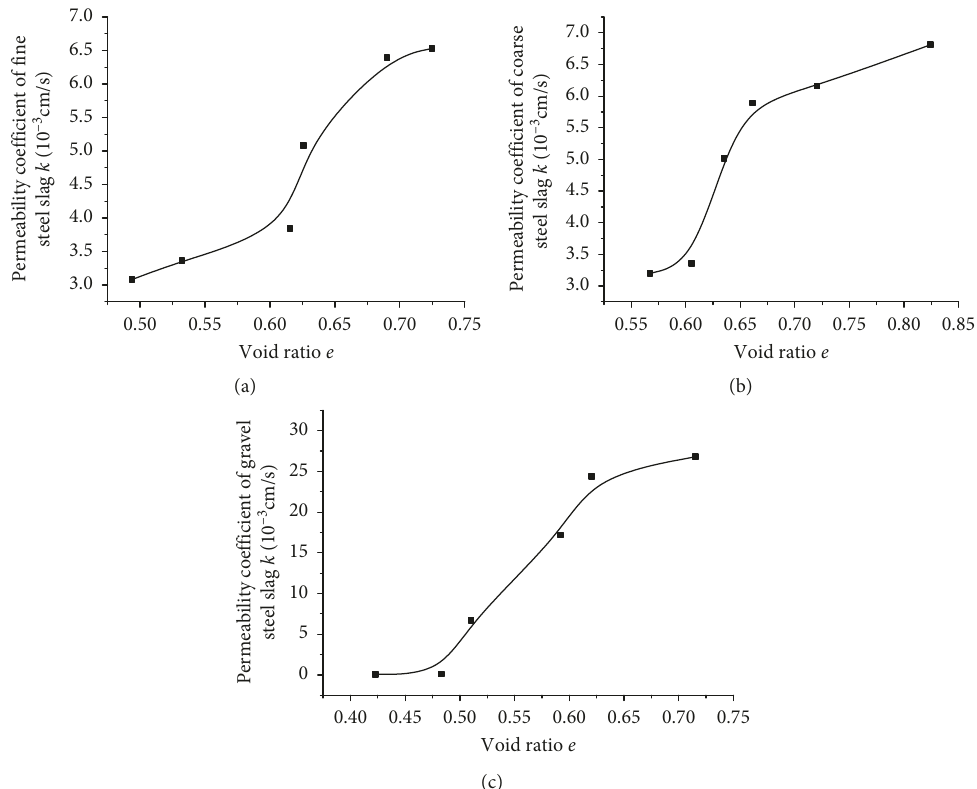
Figure 6: Permeability curves of three kinds of steel slag with changing void ratios: (a) fine steel slag; (b) coarse steel slag; (c) gravel steel